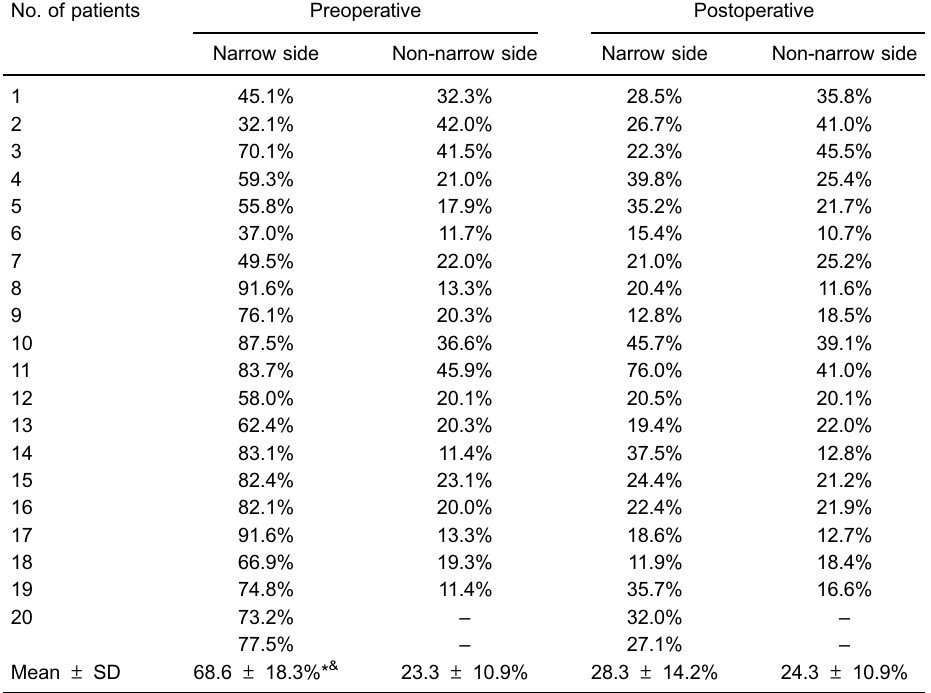
Table 2. Percentage pressure contribution of the front plane of the inferior turbinate to the entire nasal cavity pressure in 20